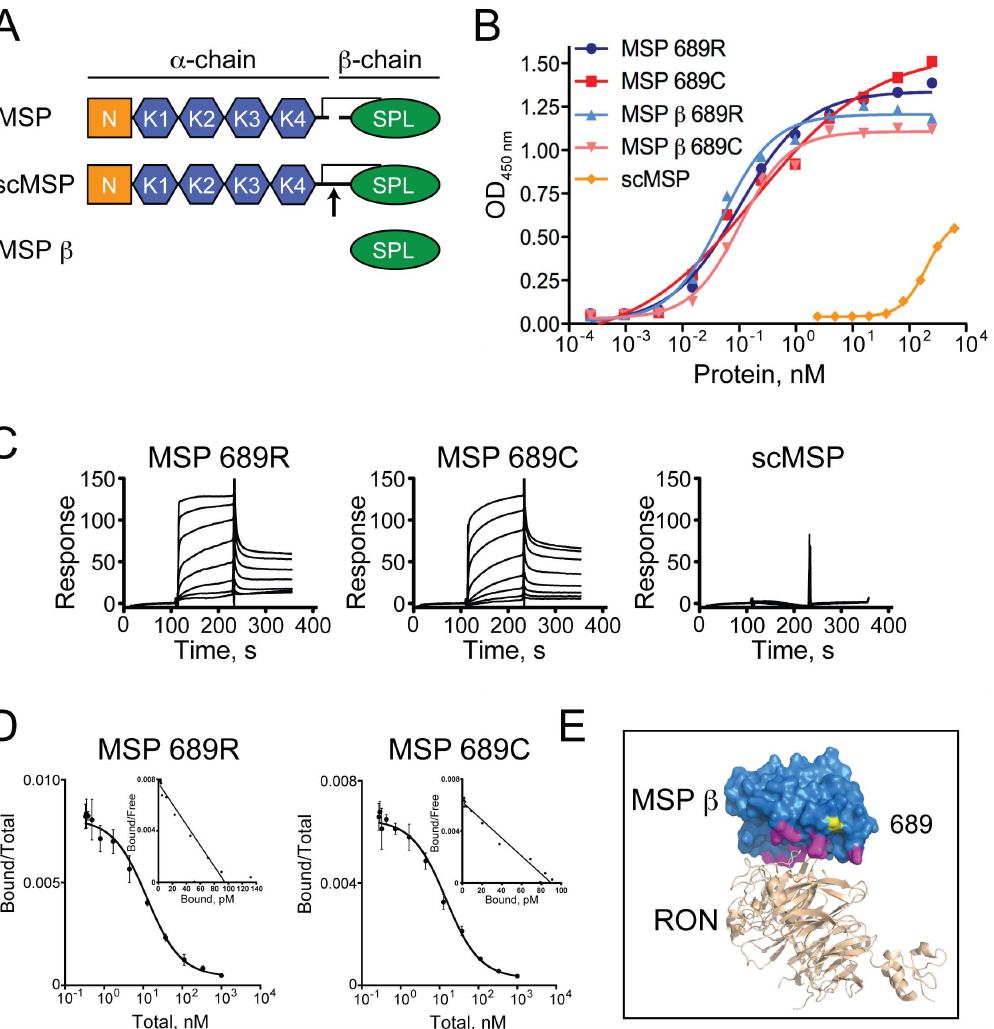
Figure 4. The 689C polymorphism in MSP does not affect binding to RON. (A) Overview of recombinant human MSP proteins used in this study. MSP a - and b -chains, PAN domain (N), kringle domains (K), serine protease-like domain (SPL) are indicated. scMSP is inactive due to the R483E mutation at the proteolytic cleavage site (arrow). 689R and 689C versions of all MSP proteins were generated. (B) Cell-free binding assay consisting of plate bound RON-Fc and soluble MSP. Means of three replicates per group are shown. Lines represent dose-response curves fit to a 4 parameter equation, which yielded EC 50 values of 0.1, 0.2, 0.05 and 0.1 nM for MSP 689R, 689C, MSP b 689R and MSP b 689C, respectively. (C) SPR analysis of MSP proteins binding to immobilized RON Sema/PSI, showing relative response in response units. Data are representative of three independent experiments. (D) Radioligand binding assay of MSP binding to RON. Competition binding to 3T3-hRON cells (large graphs) used to generate affinities and Scatchard plots (inset graphs) are shown. Mean + / 2 SD of three independent experiments is shown. (E) Homology model of the structure of RON Sema/PSI (PDB code 4FWW) in beige bound to MSP b (PDB code 2ASU) in blue. RON and MSP b were globally aligned to the Met/HGF b complex (PDB code 1SHY). Predicted locations of the MSP b contact residues within 4 A˚ of RON are highlighted in magenta. MSP b residue arginine 689 was mutated to a cysteine and is shown in yellow.